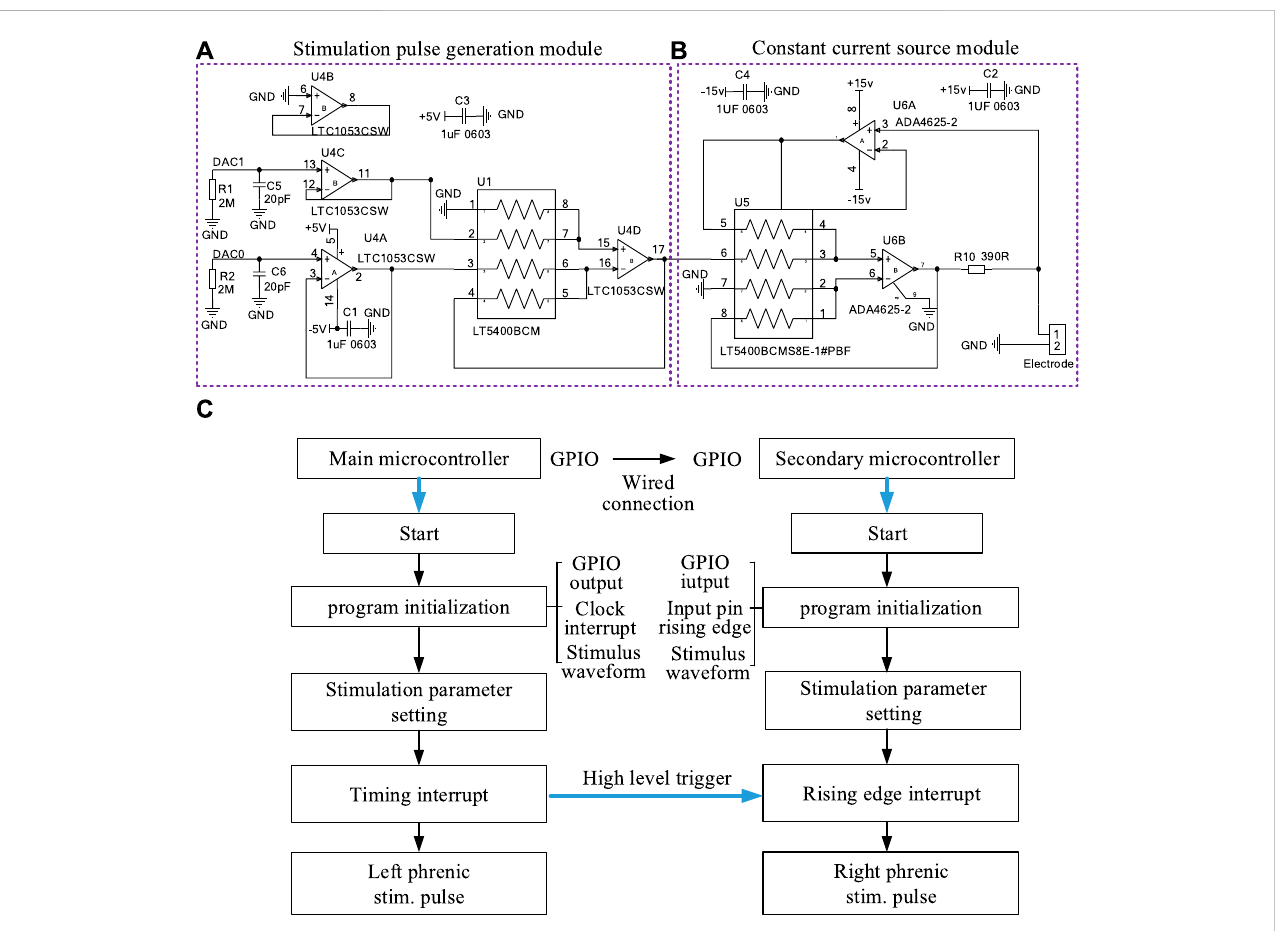
FIGURE 2 The hardware circuitofastimulator in DPsystem and fl owchart of theoutputofstimulationwaveform. (A) Stimulation Pulse GenerationModule and (B) Constantcurrentsourcemoduleofastimulator. (C) Theprogramexecution fl